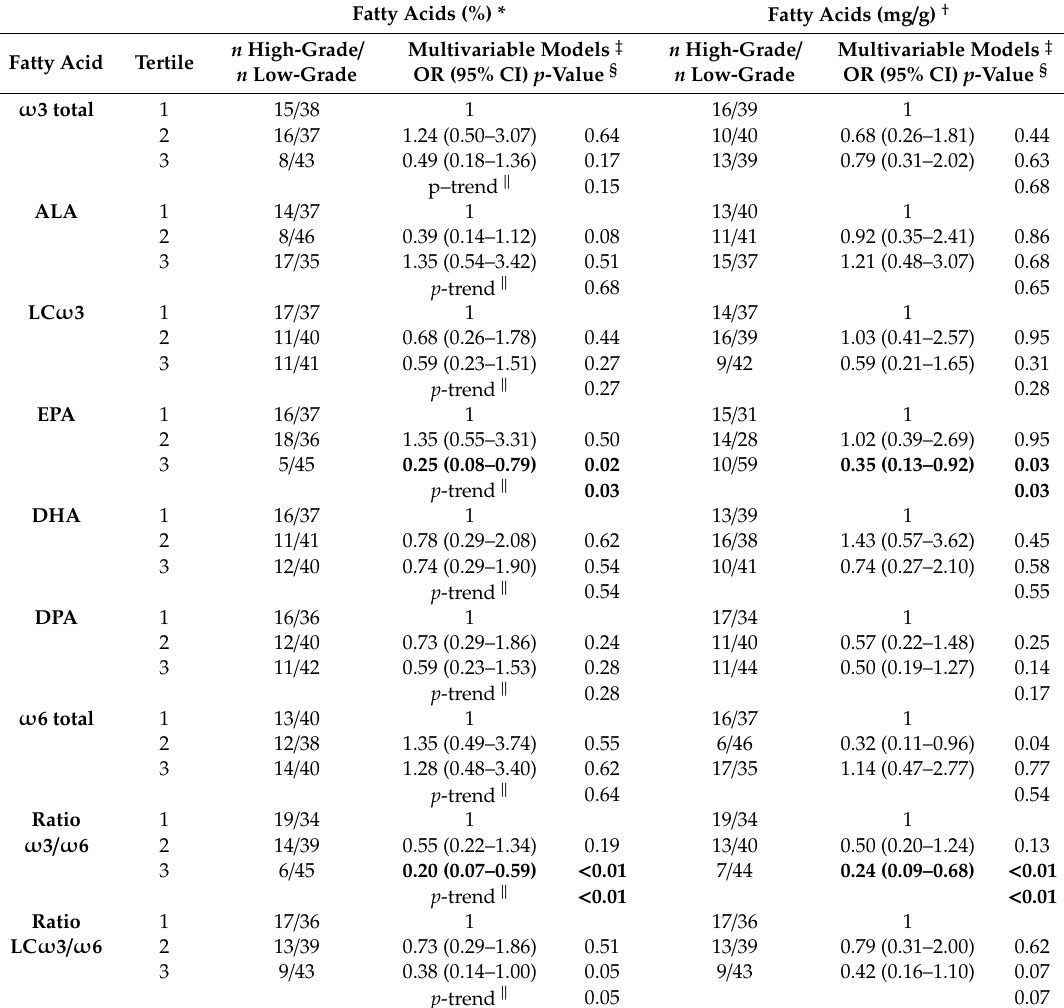
Table 3. Associations between fatty acid profiles of prostate tissue and high-grade prostate cancer. Fatty Acids (%) *